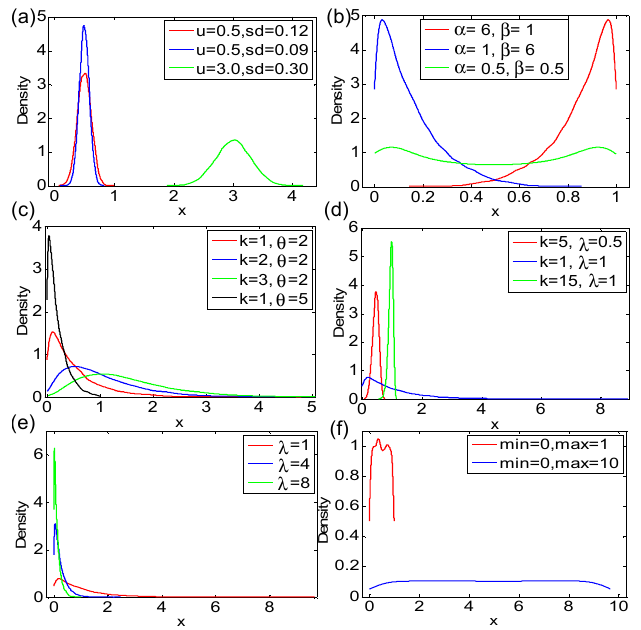
Figure 3. The PDF distribution of simulated data in Scheme 1. ( a – f ) refer to Gaussian distribution, beta distribution, gamma distribution, weibull distribution, exponential distribution and uniform distribution, respectively. Table 1. Calculation results of the three methods for the simulated data in Scheme 1.